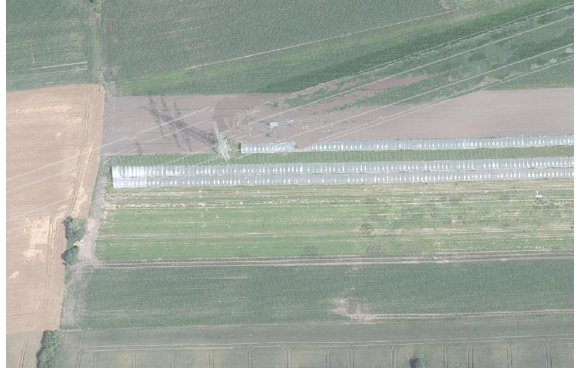
Figure 7. Error caused by missing powerline-informations in DSM